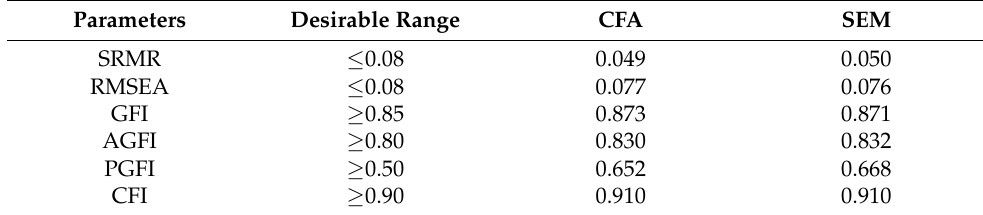
Table 3. Goodness of fit for Model ETPB.